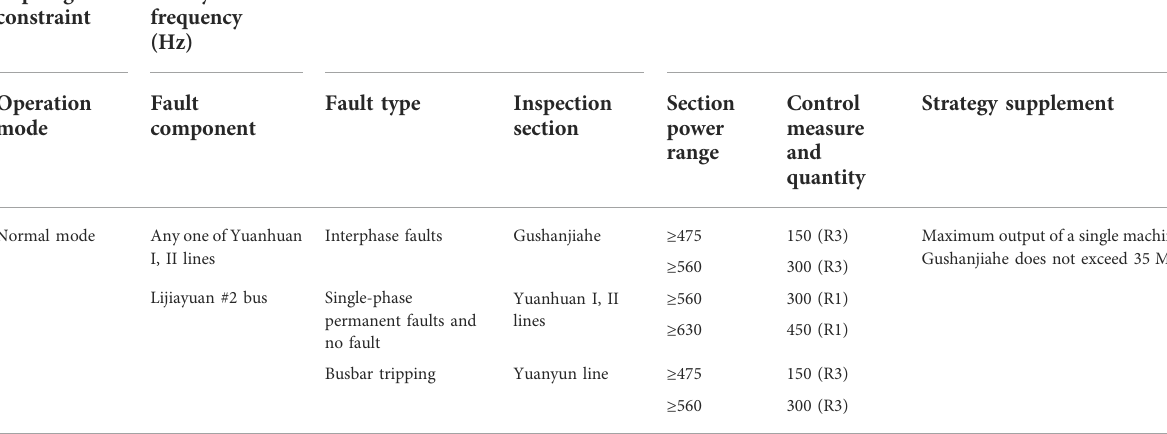
TABLE 1 Strategy table for section composition of Yuanhuan I, II lines, Shibo line, and Boyuan line. Topological